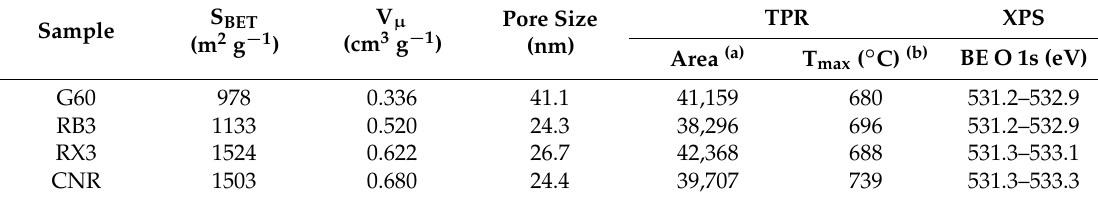
Table 1. Physicochemical properties, TPR and XPS results of the activated carbon (AC) support.